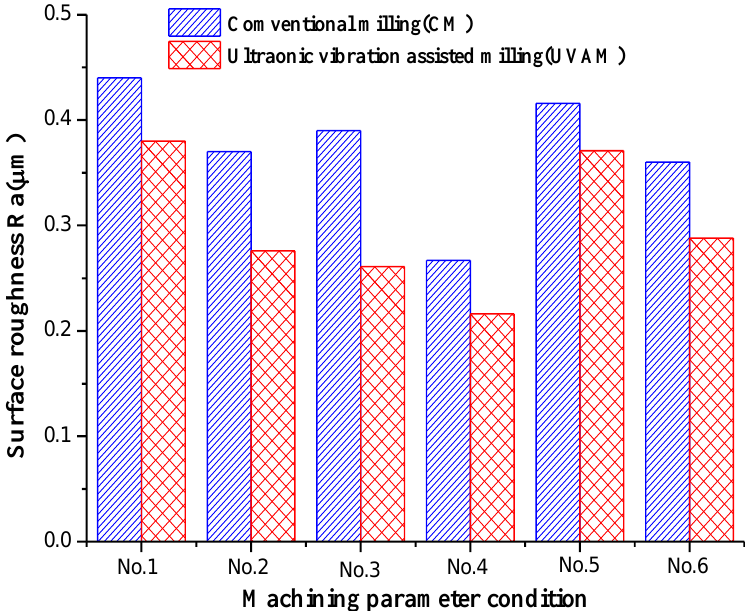
Figure 4. Comparison of surface roughness under different parameters.